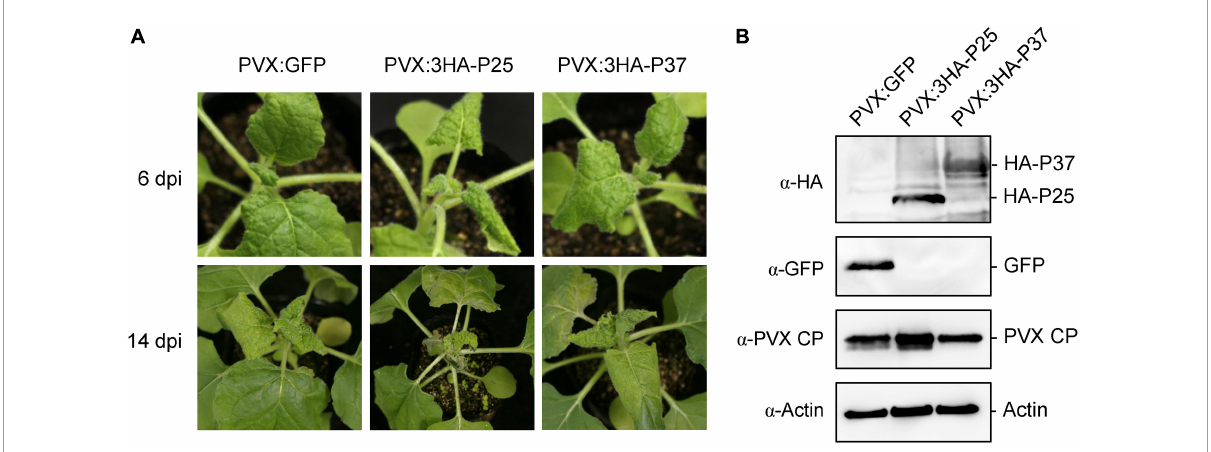
FIGURE7 Effects of Firespike leafroll-associated virus (FLRaV) P25 and P37 on modulation of the symptom development and viral titer of potato virus X (PVX) in wild-type Nicotiana benthamiana . (A) N. benthamiana seedlings were agroinfiltrated with PVX:GFP, PVX:3HA-P25, or PVX:3HA-P37 at 6 days post infiltration (dpi) and 14 dpi. N. benthamiana seedlings agroinfiltrated with PVX: green fluorescent protein (GFP) were served as a negative control. (B) Western blot (WB) analysis of FLRaV P25 and P37 protein accumulation in systemic leaves shown in (A) . HA-P25, HA-P37, GFP, and PVX-CP were detected using antibodies to HA tag ( α -HA), GFP ( α -GFP), and to PVX CP ( α -PVX CP), respectively. WB analysis performed using an antibody to actin was served as the loading